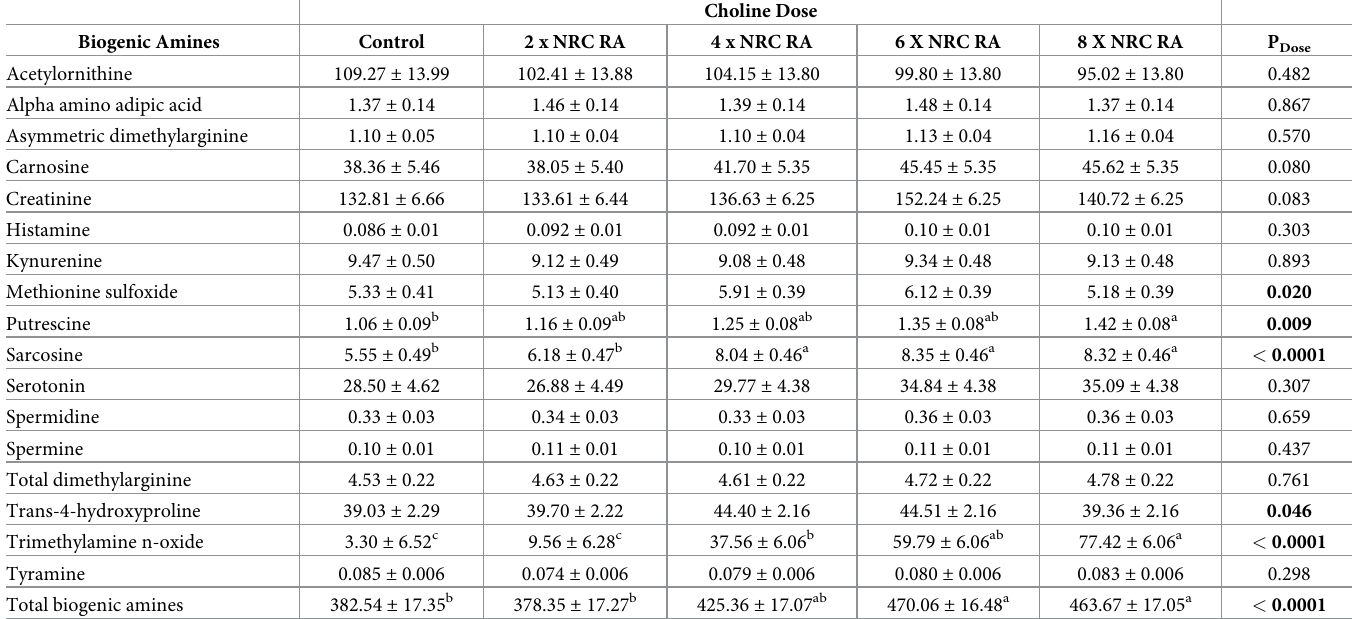
Table 2. Mean serum concentrations ( μ M) of biogenic amines determined by DI-MS in overweight cats (n = 14) receiving control (no additional choline supplemen- tation, 1.2 x NRC RA, 77 mg/kg BW 0.67 ), choline at 2 x NRC RA (126 mg/kg BW 0.67 ), 4 x NRC RA (252 mg/kg BW 0.67 ), 6 x NRC RA (378 mg/kg BW 0.67 ), and 8